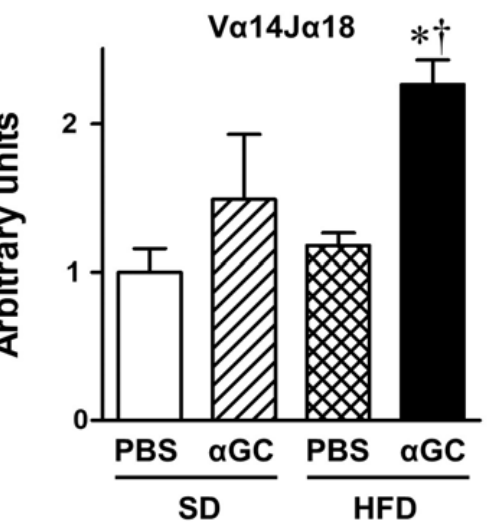
2.2. α GC-Induced iNKT Cell Accumulation in Aortic Tissues iNKT cell accumulation into aortic tissues quantified by V α 14/J α 18 gene expression was comparable between the SD-PBS and the HFD-PBS groups. α GC injection significantly enhanced iNKT cell accumulation in the HFD- α GC group, but not in the SD- α GC group (Figure 1).